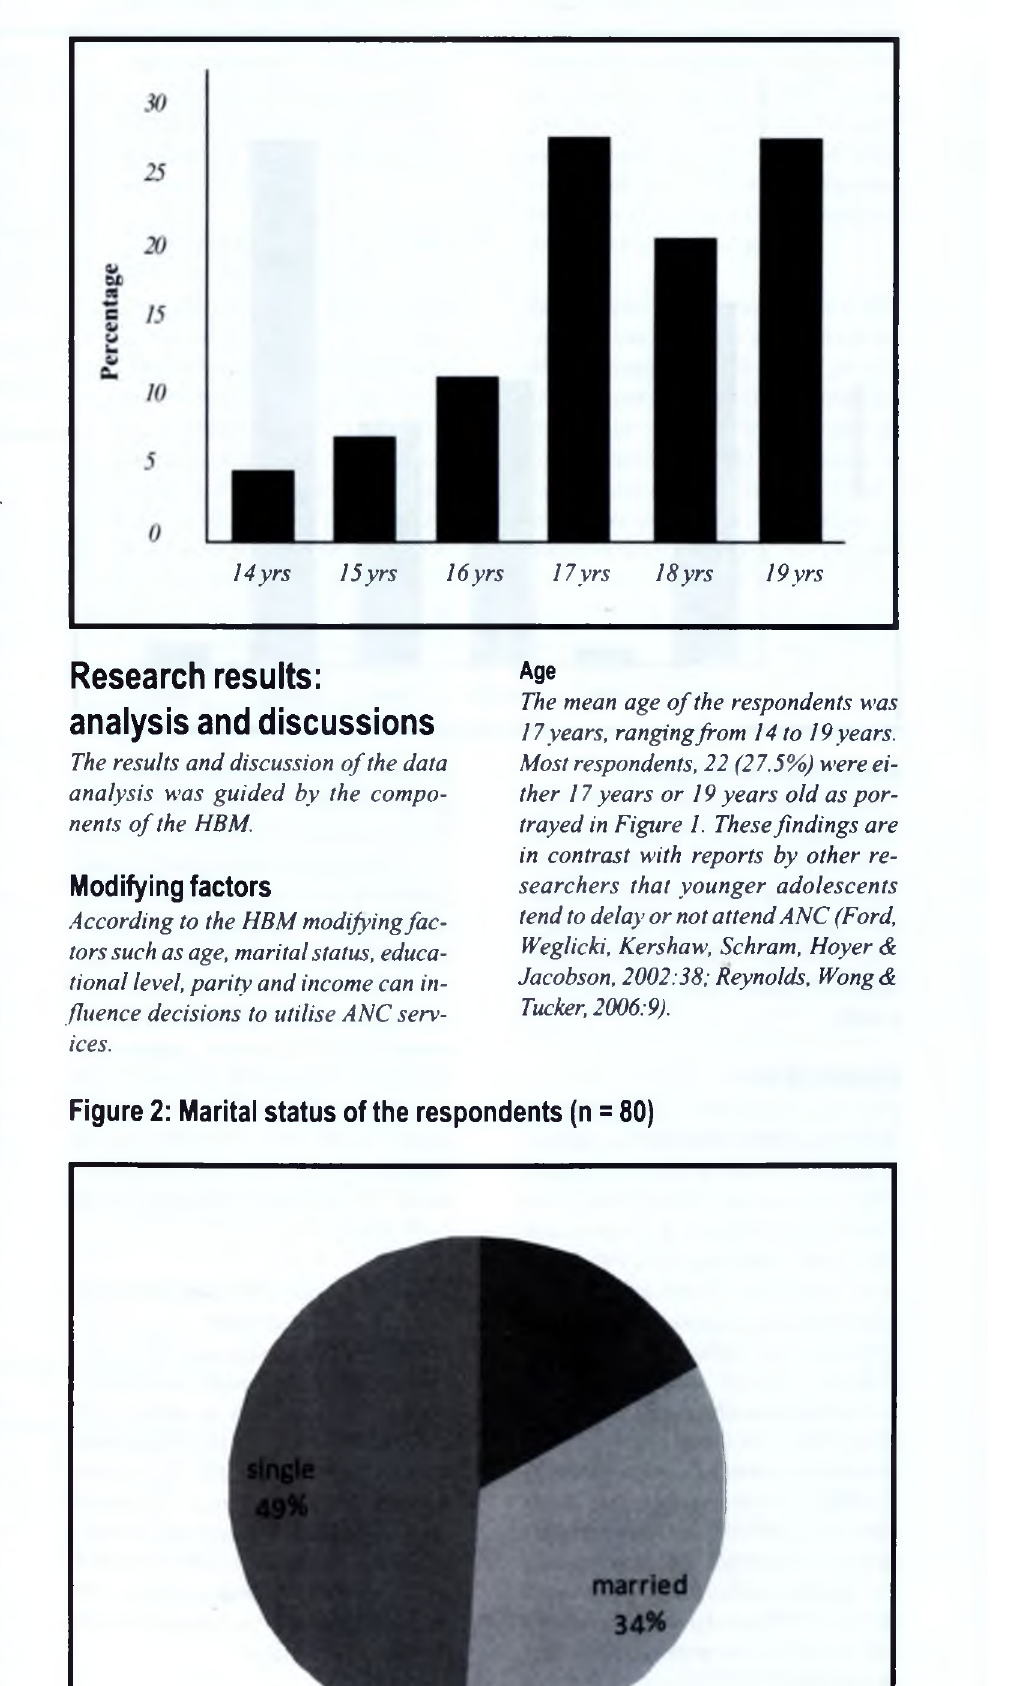
Figure 1: Age of the respondents (n=80)